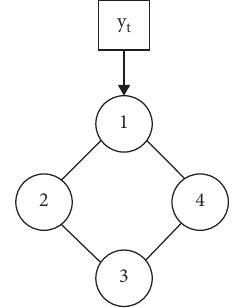
Figure 1: Communication topology.